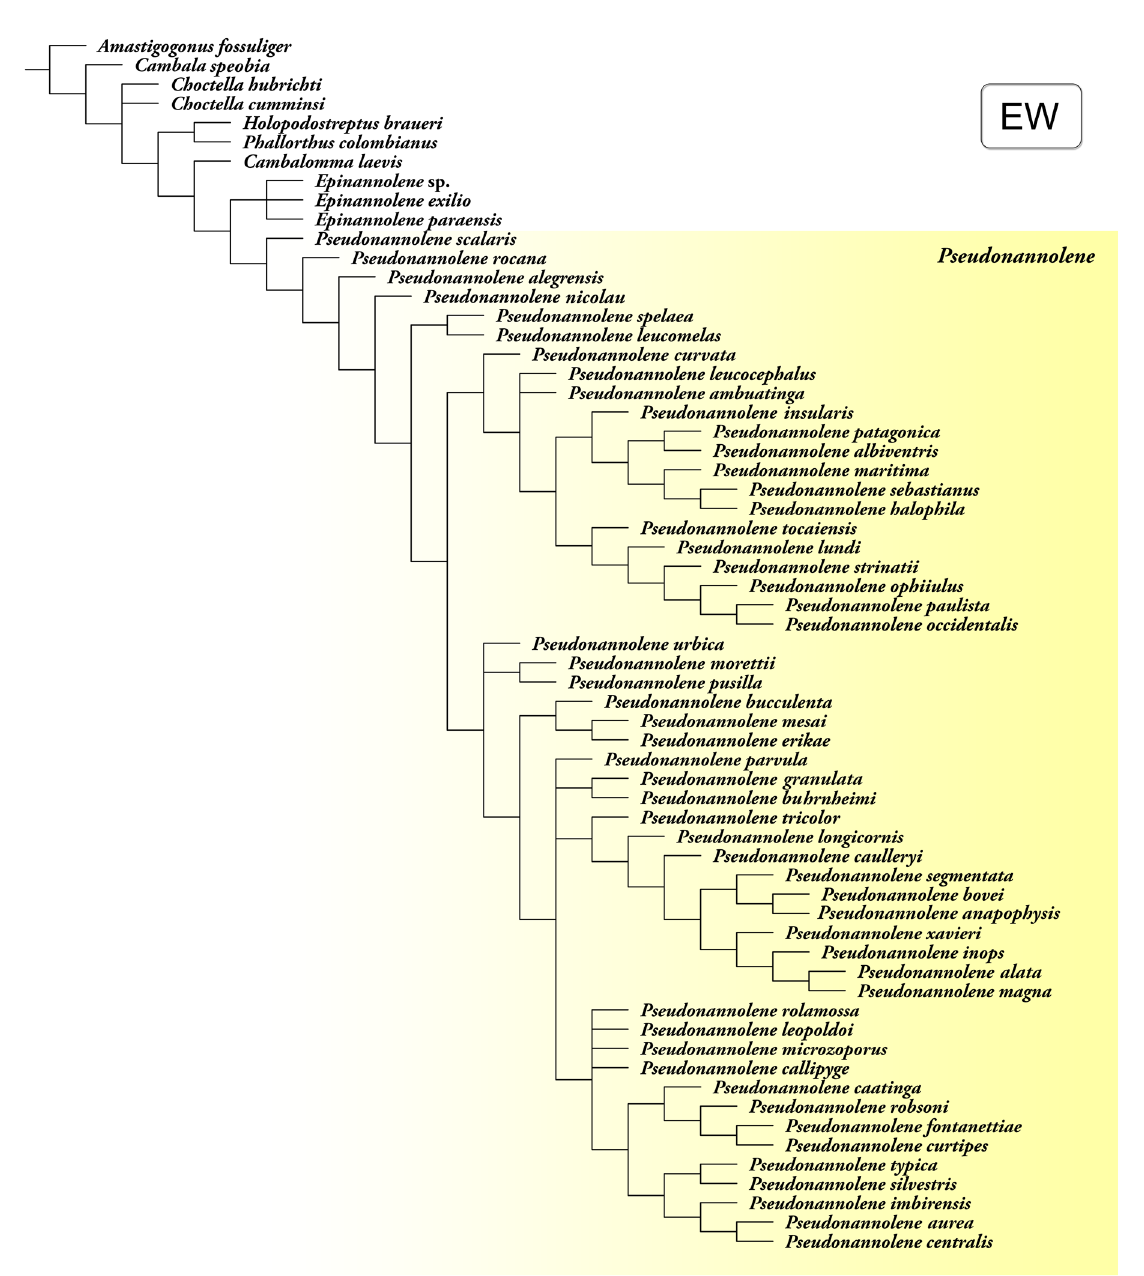
Fig. 5. Strict consensus of 22 equally parsimonious trees with equal